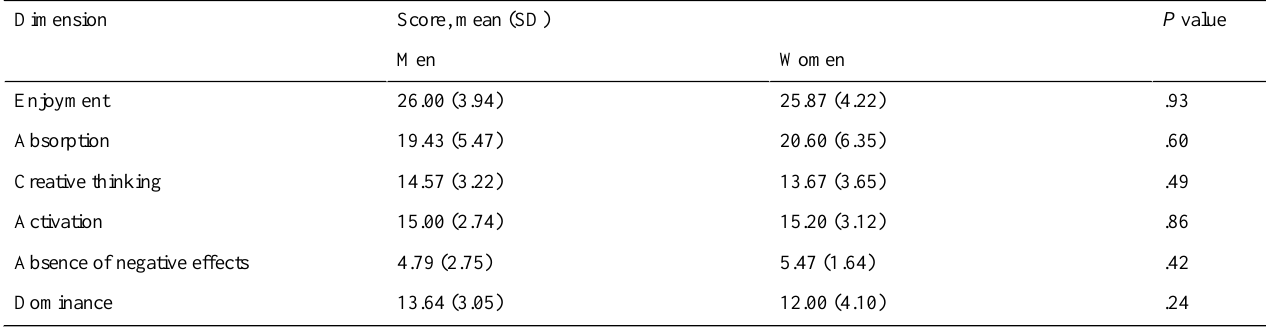
Table 2. Data of each Gameful Experience (GAMEX) scale dimension by